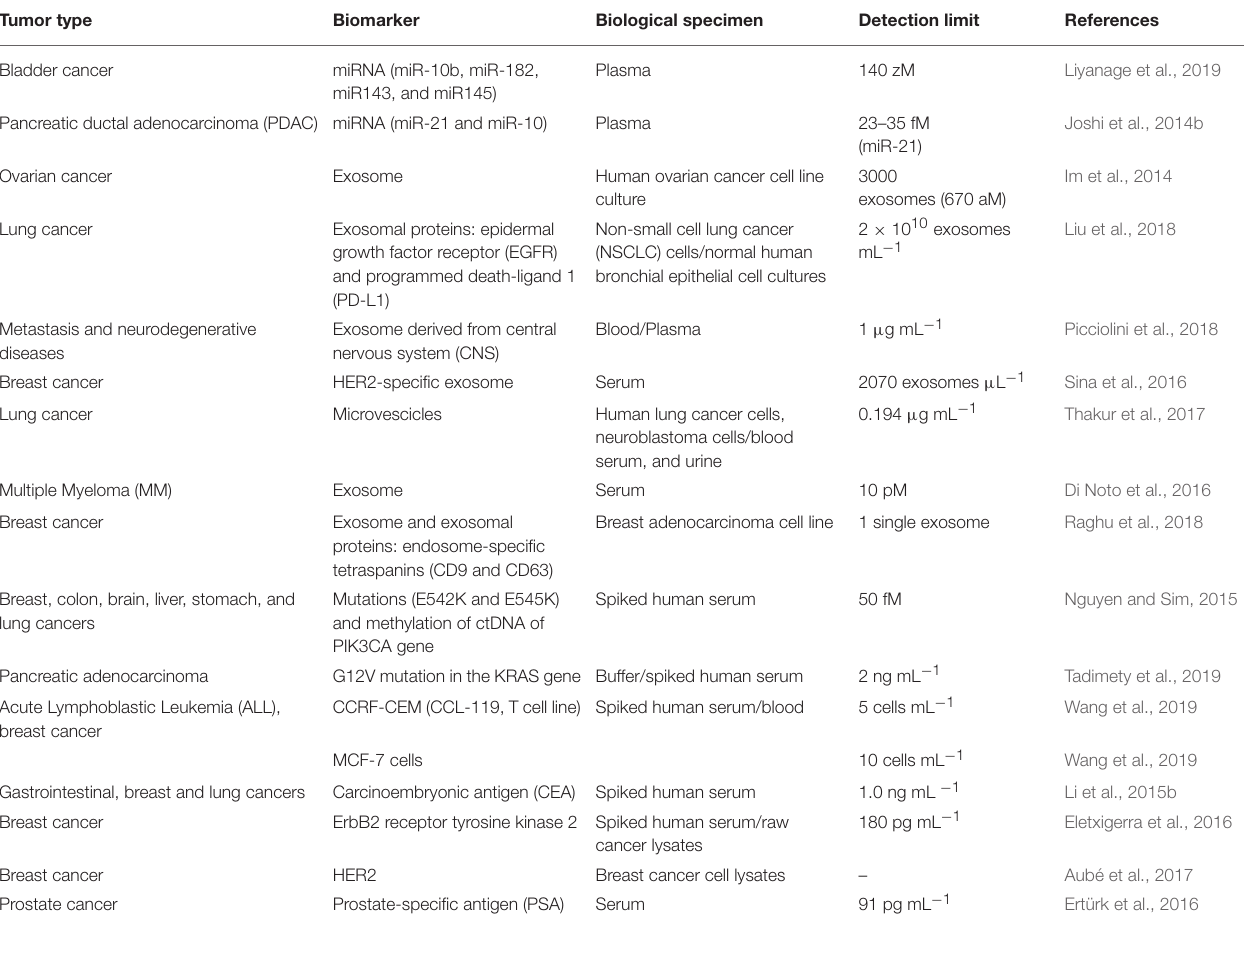
TABLE 1 | Performances of plasmonic platforms for detection of circulating biomarkers in